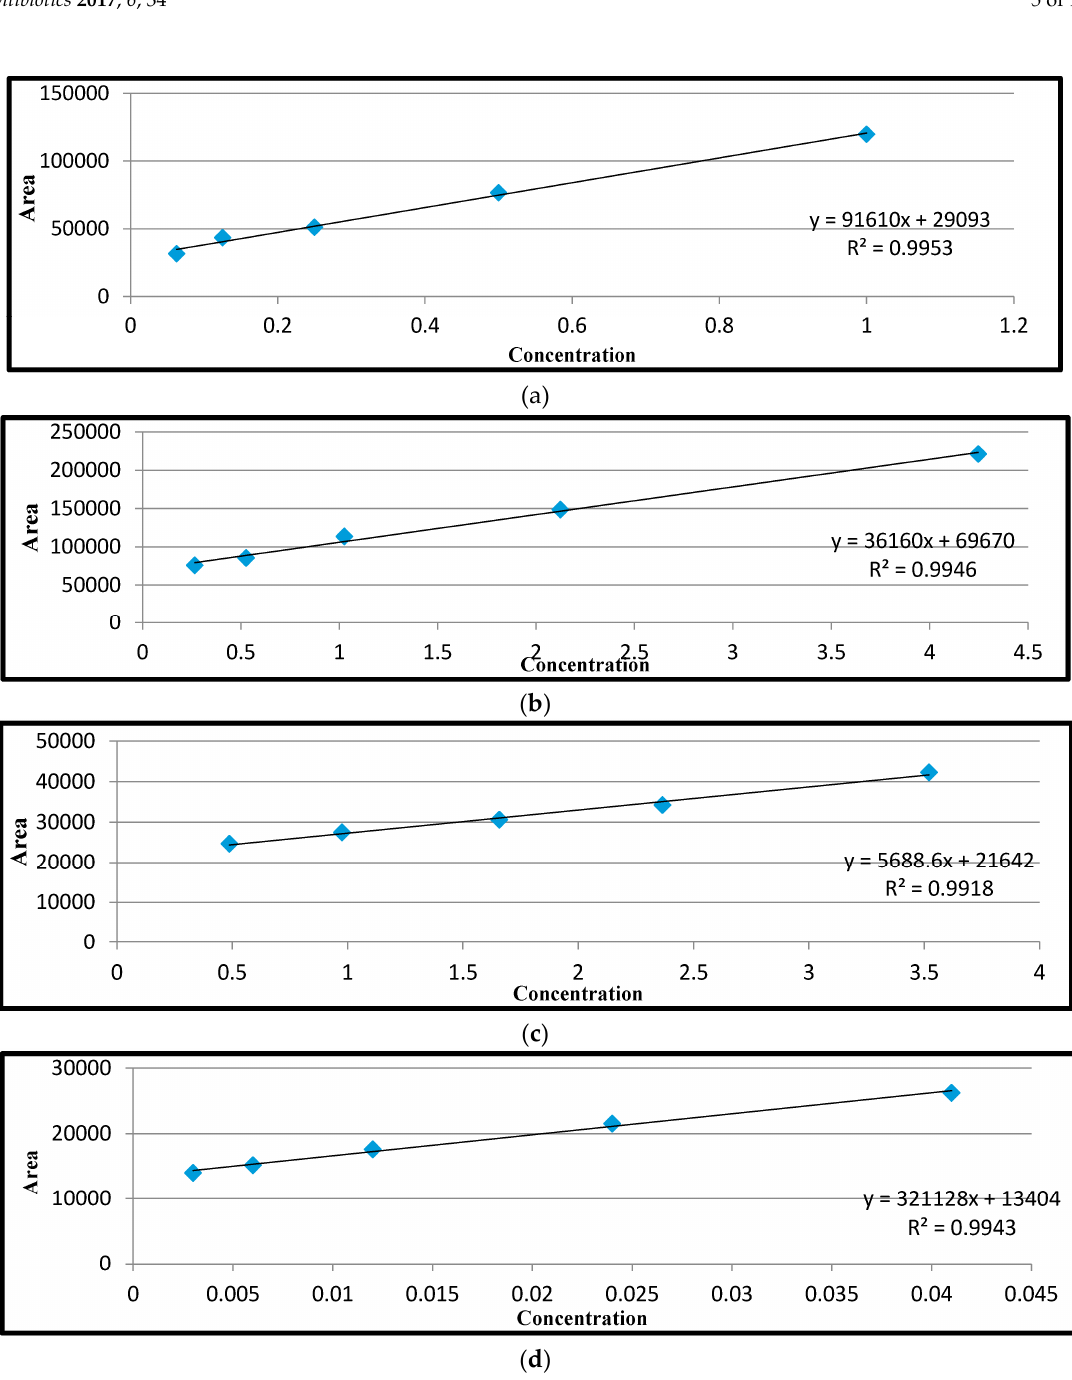
Figure 1. HPLC standard calibration curves for ( a ) sulphonamide standards at 1, 0.5, 0.25, 0.125, and 0.0625 µ g/kg; ( b ) tetracycline standards at 0.2654, 0.5308, 1.0616, 2.1232, and 4.2464 µ g/mL; ( c ) streptomycin showing linearity over the concentration range of 0.488, 0.976, 1.953, 2.485, and 3.102 µ g/kg; and ( d ) ciprofloxacin standards at 0.003, 0.006, 0.012, 0.024 and 0.048 µ g/kg run on HPLC under the Fluorometric Detector (FD).